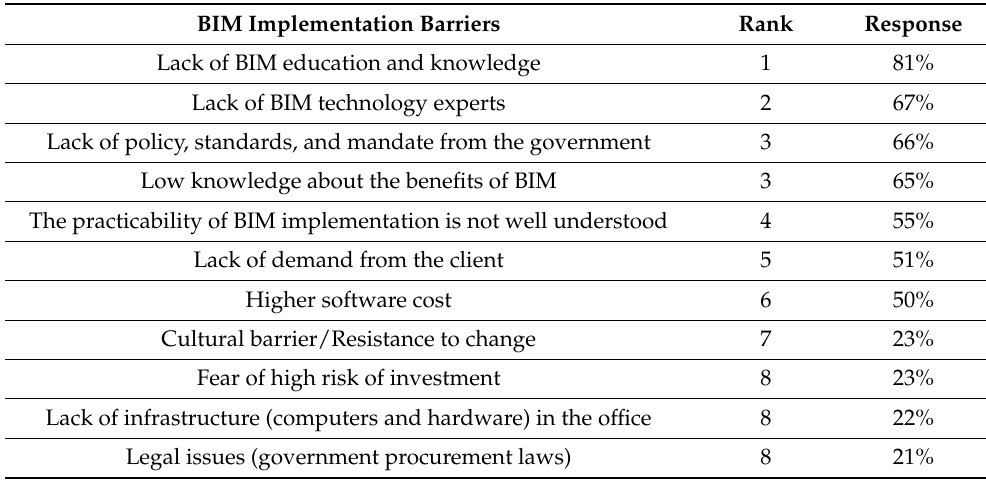
Table 3. BIM implementation barriers in